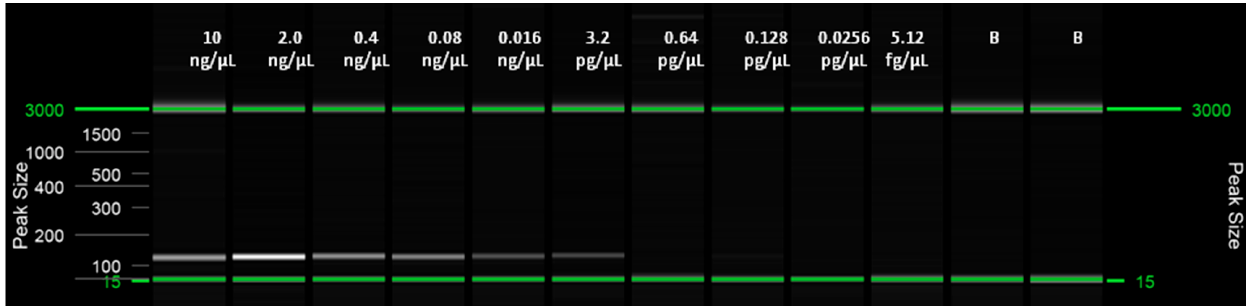
Figure 3. LoD assay of visual LAMP based on WTB adults using serial 1:5 dilutions (from 10 ng/µL to 5.12 fg/µL). Plants 2021 , 10 , x FOR PEER REVIEW